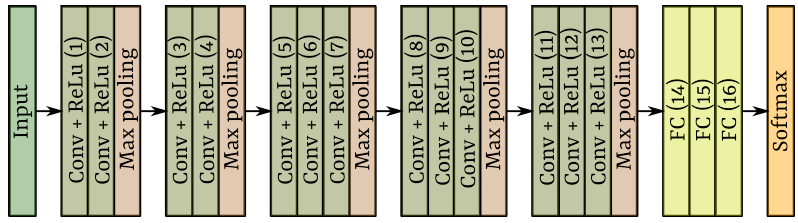
Figure 8. The VGG standard architecture.